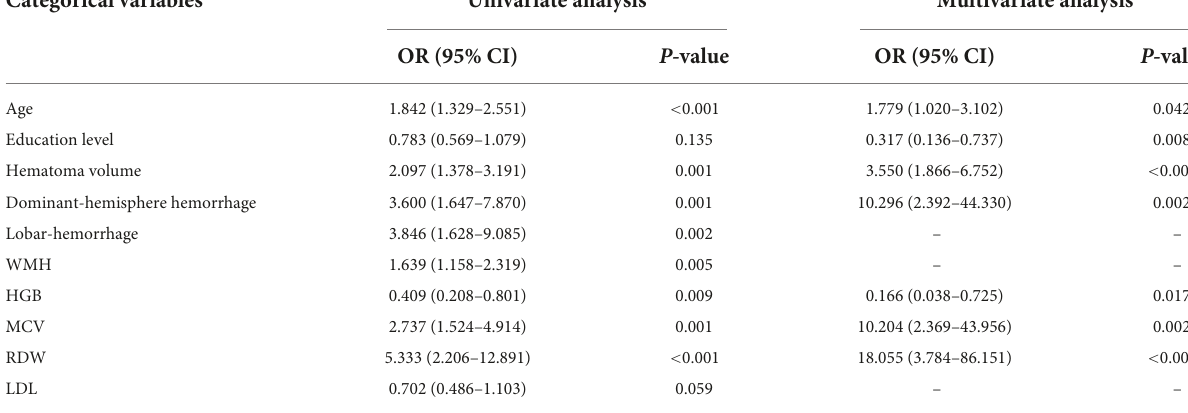
TABLE 3 Univariate and multivariate logistic regression analysis to predict PSCI in ICH patients.